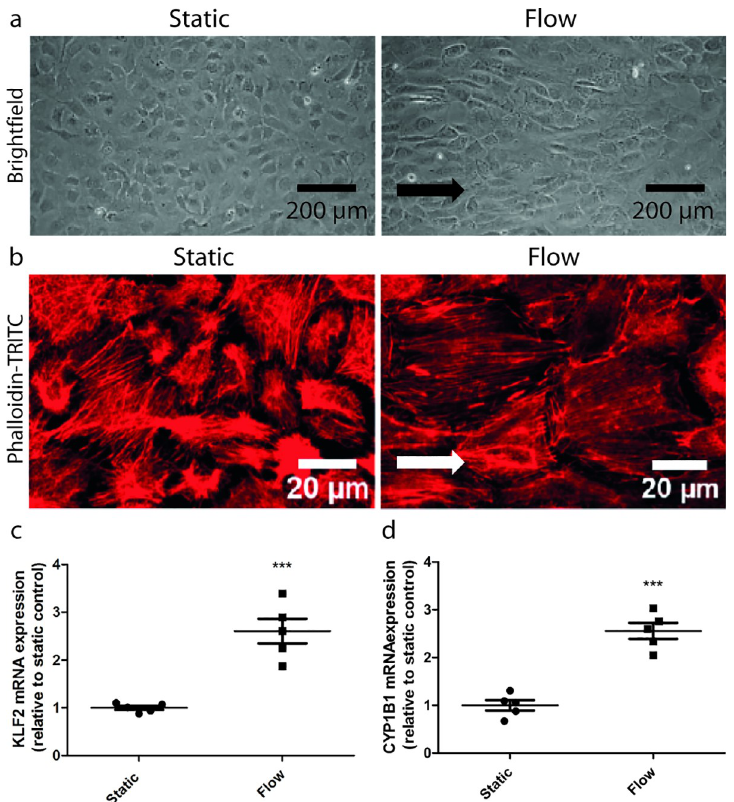
Fig 1. Laminar flow induces morphological changes and increases expression of key regulators of the shear stress response in GEnC. mGEnCs were cultured under static conditions or under a laminar flow of 5 dyn/cm 2 for 7 days. Representative brightfield images ( A ) and representative fluorescent images of β -actin filaments stained with Phalloidin-TRITC ( B ). Arrows indicate the direction of the flow. mRNA expression levels of the shear stress responsive genes KLF2 ( C ) and CYP1B1 ( D ) in mGEnCs cultured under either static conditions or flow. ��� p <